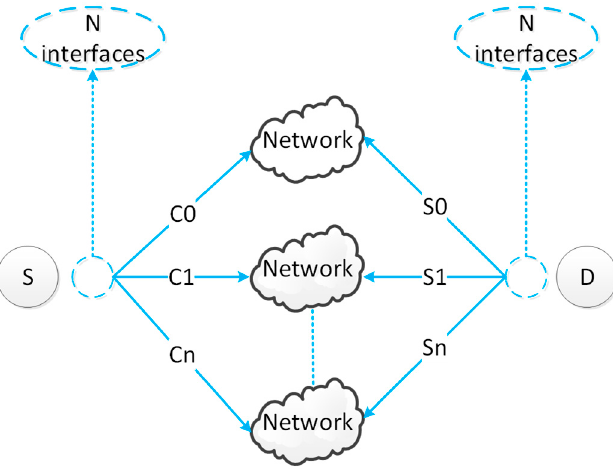
Figure 6. SCTP multi-path transmission model.